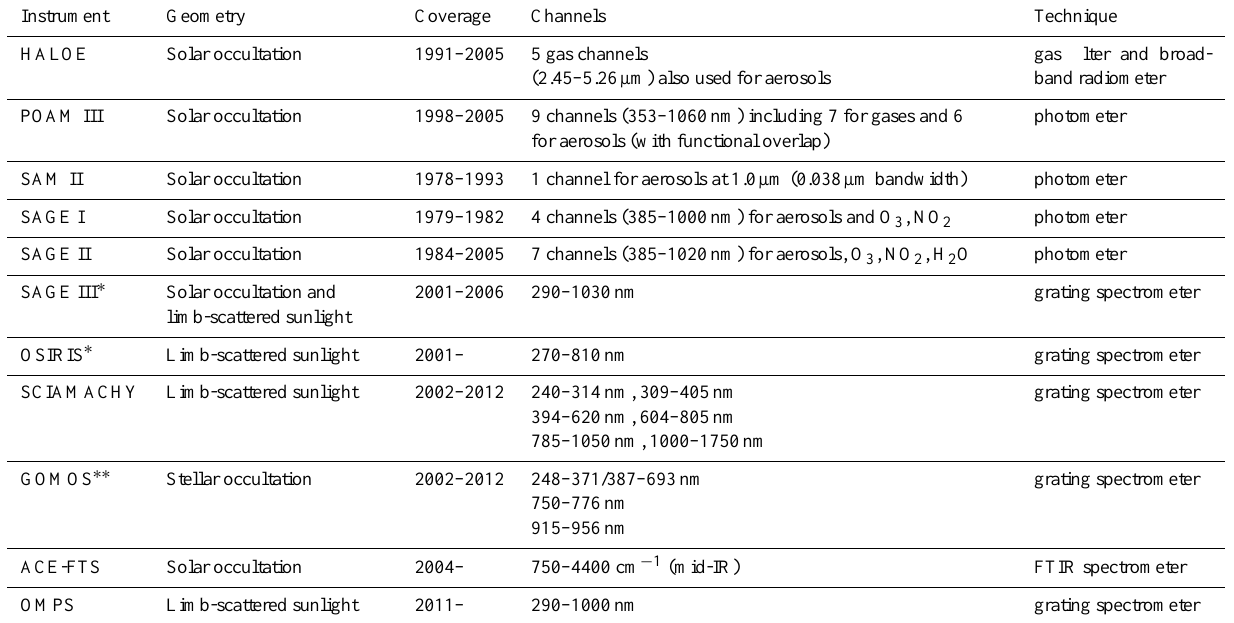
Table 1. Satellite retrievals of aerosol extinction in the UTLS using the limb-viewing